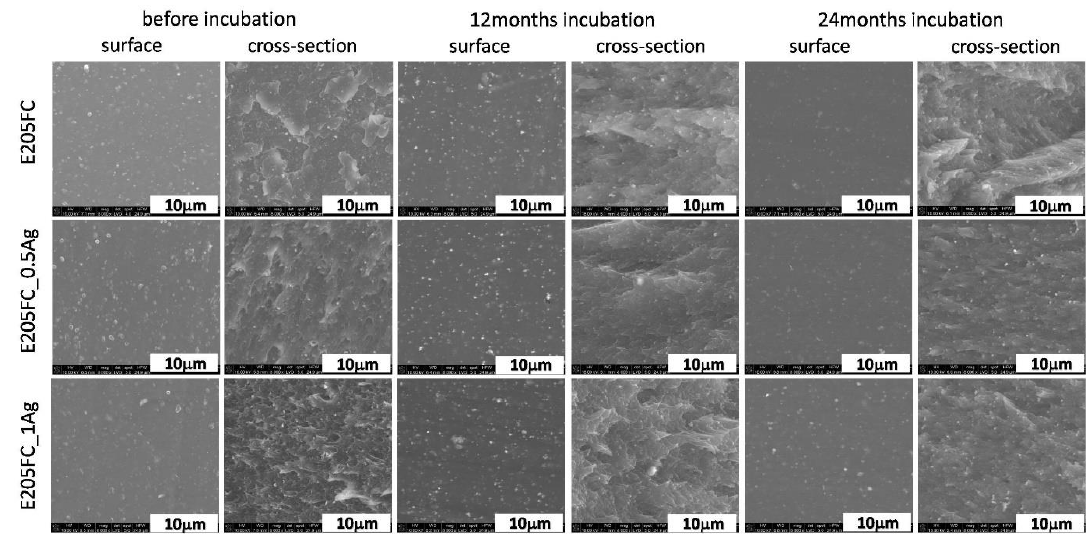
Figure 1. SEM images of surface and cross-section of pure polymer (E205FC) and polymer containing 0.5 wt % and 1.0 wt % of silver nanoparticles AgNPs before and after 12 and 24 months of incubation.